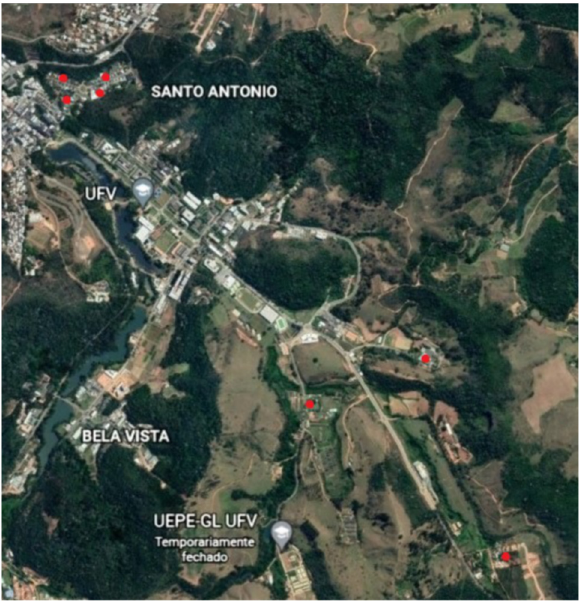
Figure 1. Black-eared opossum ( Didelphis aurita ) capture sites, Viçosa municipality, Minas Gerais State, southeastern Brazil.